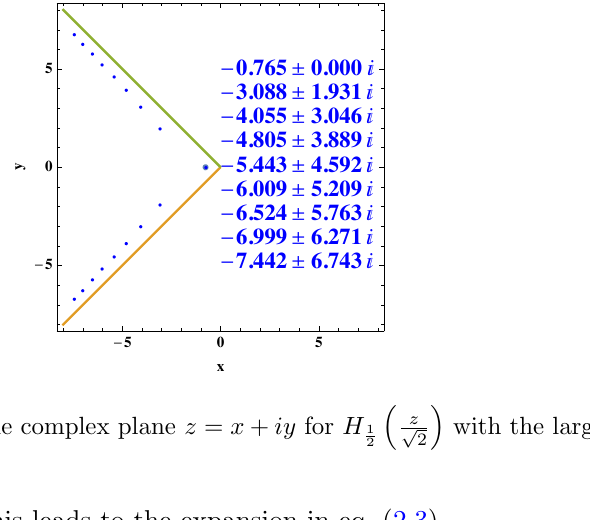
Figure 2 . Lines on the complex plane z = x + iy where the real and imaginary parts of H 1 are zero.